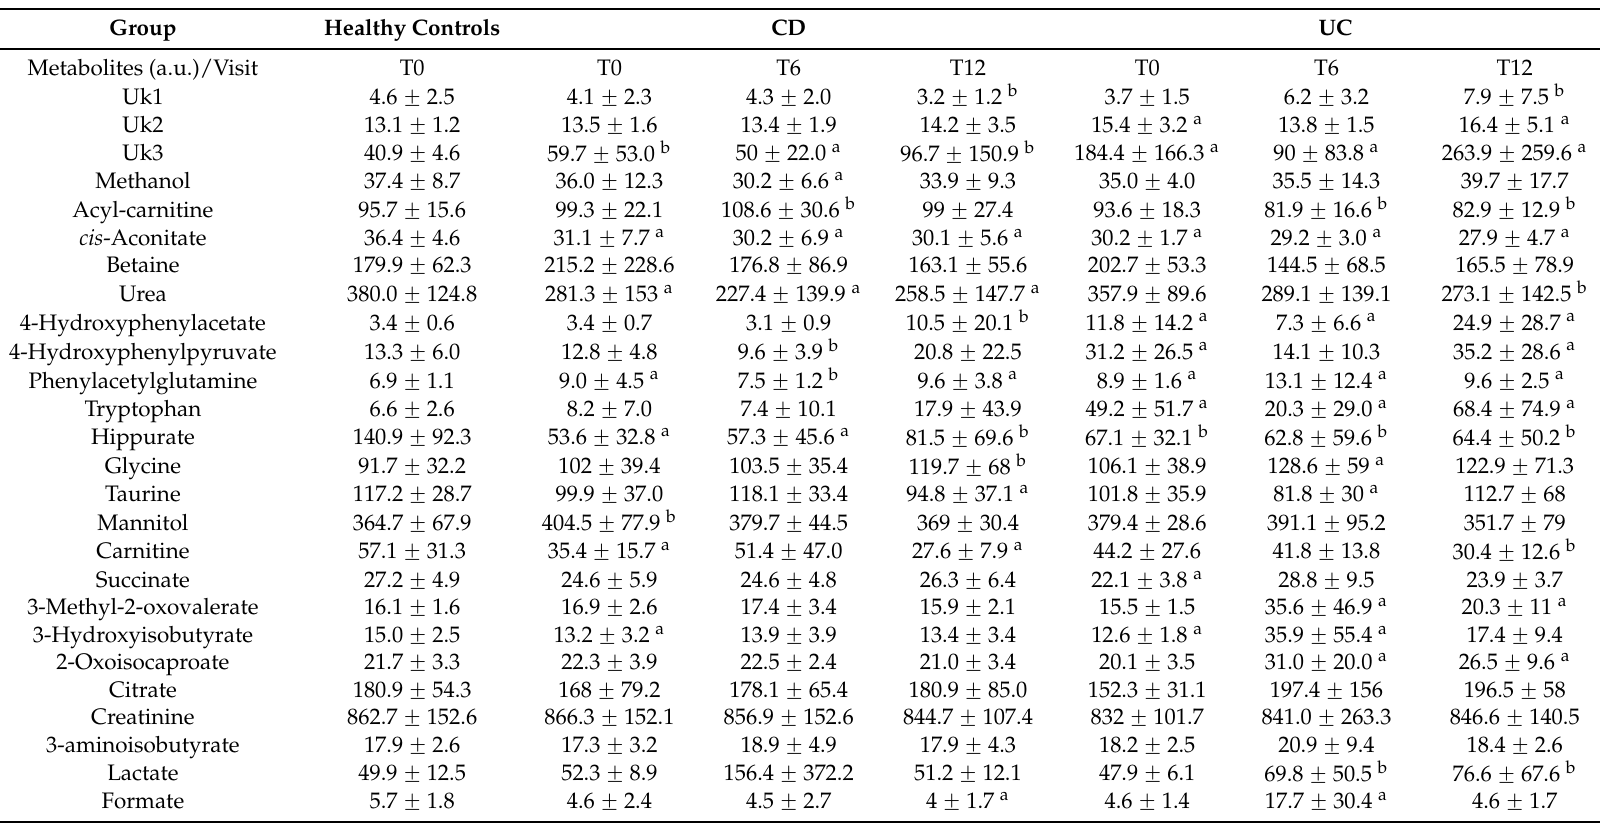
Table 2. Urine metabolite patterns in the IBD subjects and healthy